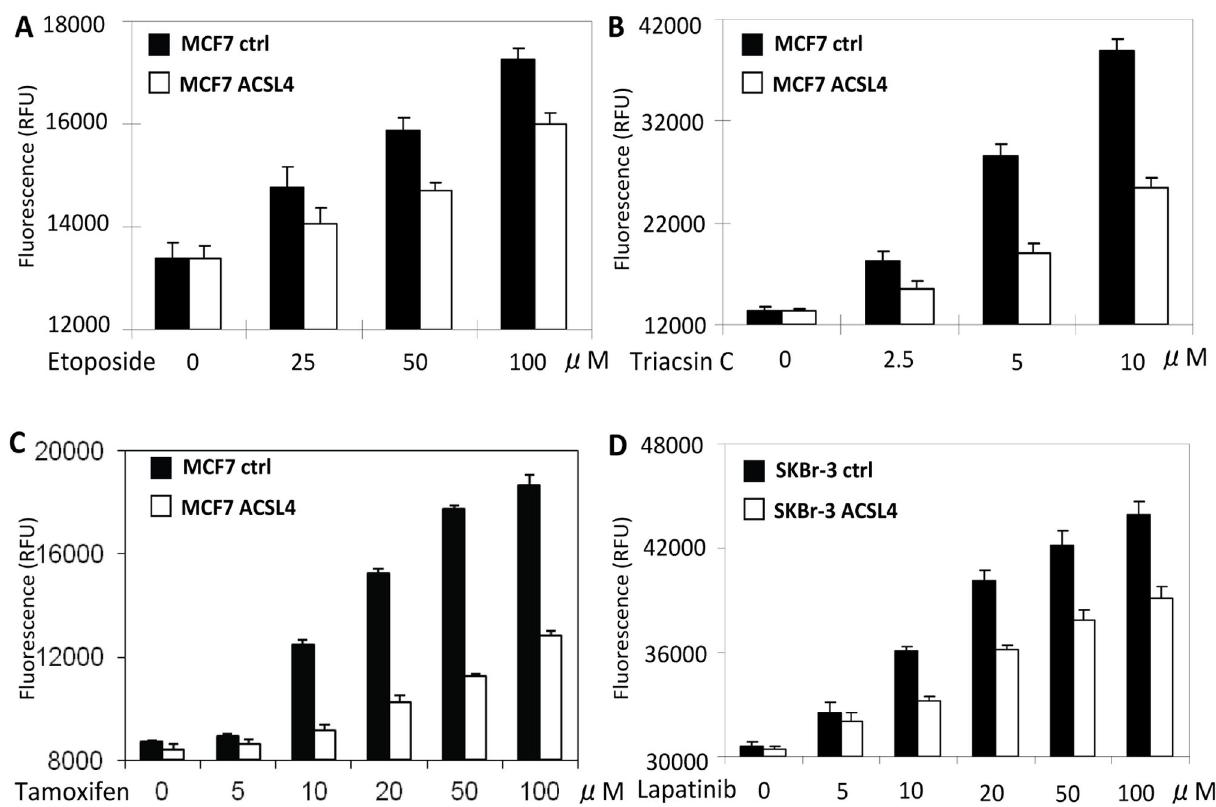
Figure 8. Effect of ACSL4 expression on apoptosis in MCF-7 and SKBr3 cells. Control and ACSL4-transfected MCF-7 cells were treated with varying doses of etoposide ( A ), triacsin C ( B ) or tamoxifen ( C ) for 48 hours and apoptosis measured as described in the text. For Panel D , control and ACSL4-transfected SKBr3 cells were treated with lapatinib for 48 hours and apoptosis measured as described in the text. Results shown are the means of triplicate determinations ± 1SD. Significance of the differences are A , p=0.027; B , p=0.012; C , p=0.005, D , p=0.008.